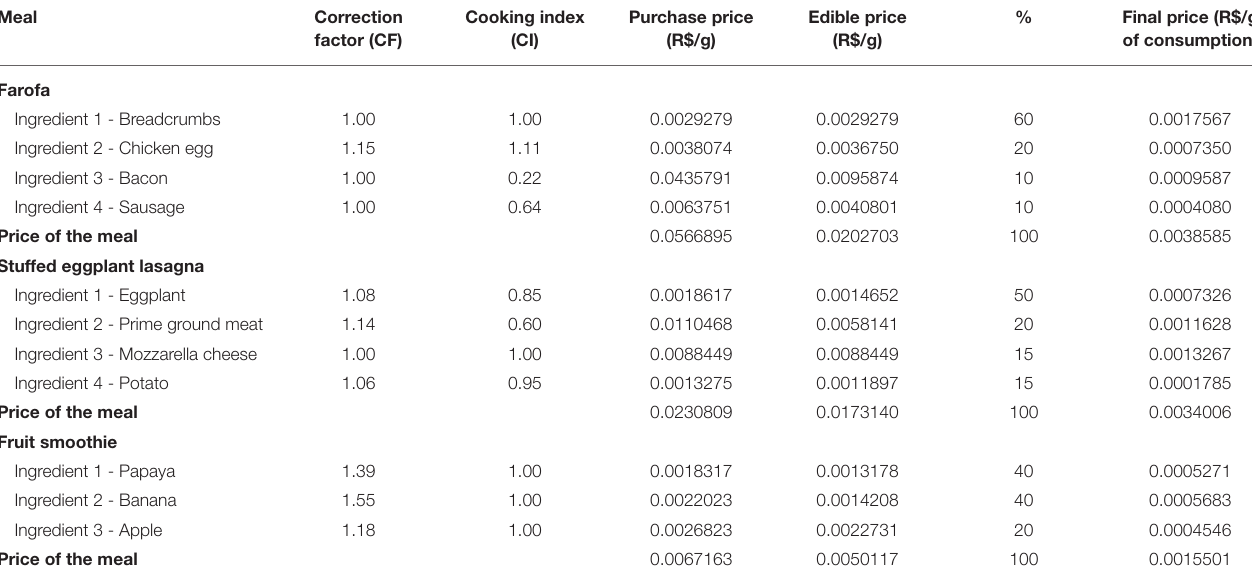
TABLE 2 | Excerpt on the application of correction factors and cooking indexes to obtain the weight of ingredients, food items, and preparations ready-to-eat in the ISA-Capital.